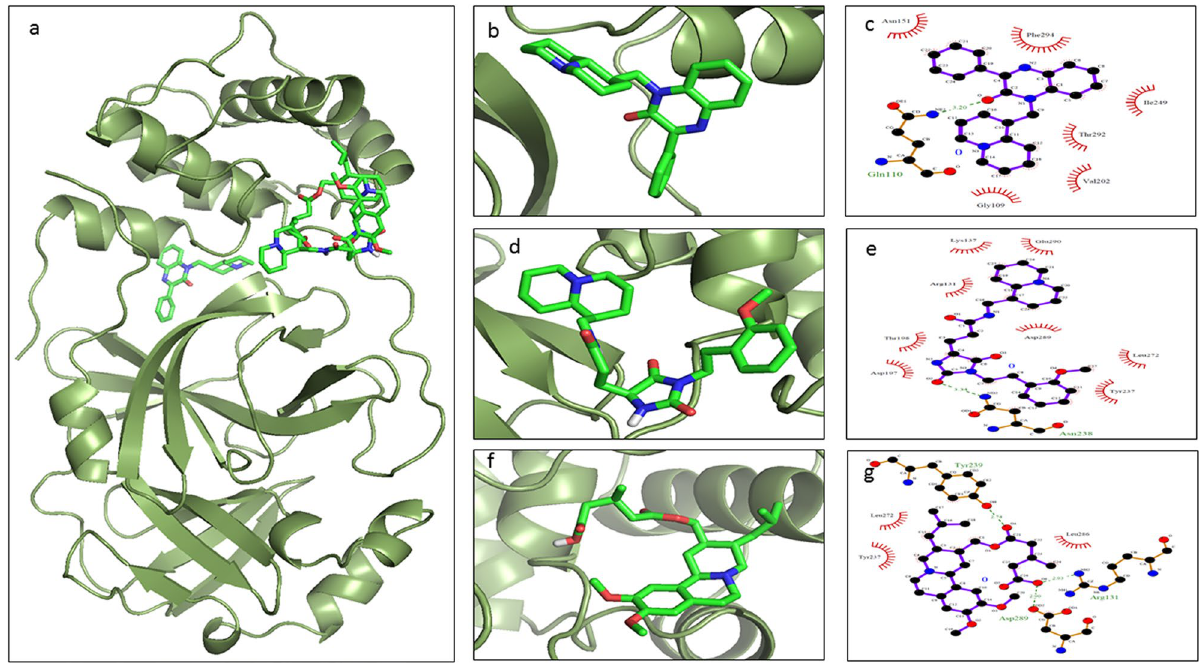
Figure 6. Docked conformations with ligand interacting plots of top 3 QZ derivatives. M pro is represented in green ribbon format, QZ80 in yellow stick form ( b ), QZ148 in red stick form ( d ) and QZ121 in blue stick form ( f ). ( c ), ( e ) and ( h ) represent the protein–ligand interaction plots for QZ80, QZ148 and QZ121 respectively. (Here the green sticks denote Carbon, blue denote Nitrogen and red denote Oxygen atoms of the